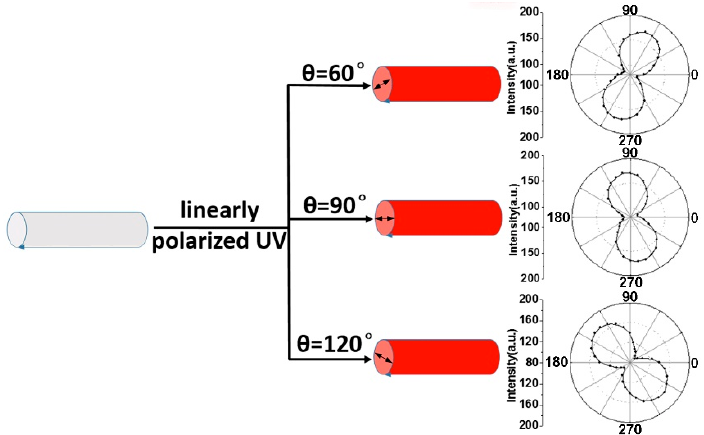
Figure 14. Modulation of waveguide polarization for optical polymer microfibers (the whole Figure 14 was reprinted with permission from Xia et al. [58]).